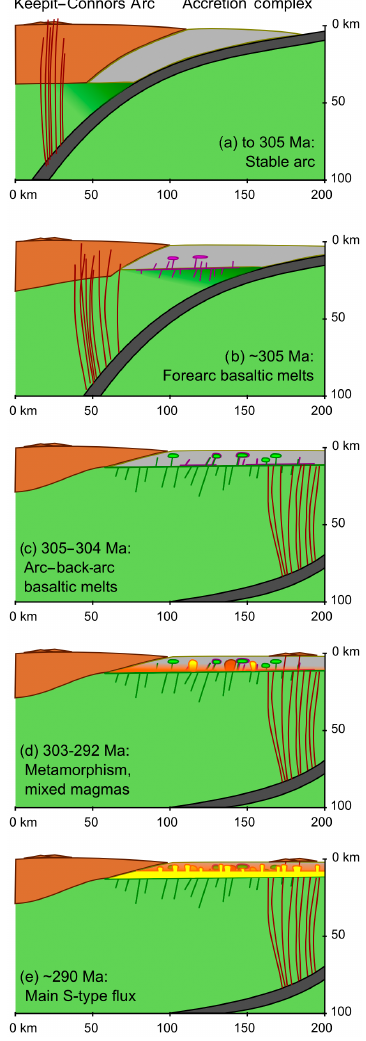
Figure 11. Chronology of early NEO magmatism: (a) Lachlan Orogen subduction zone (Keepit–Connors Arc) at ∼ 310–305Ma; (b) early extension and production of FAB-type melts, emplaced as rare, anomalous chilled margins of the Bakers Creek Suite at ∼ 305Ma; (c) continued extension at 305–304Ma, inducing mantle melting and production of main Bakers Creek Suite gabbros with back-arc (BAB) to arc-like (EAT, IAT) affinities; (d) peak meta- morphism in metamorphic complexes (Tia and Wongwibinda) and diverse magmatism, including mafic and felsic components (Bak- ers Creek and Hillgrove suites) at 303–292Ma; and (e) main flux of Hillgrove and Bundarra S-type granites at ∼ 290Ma (see Li et al., 2014,